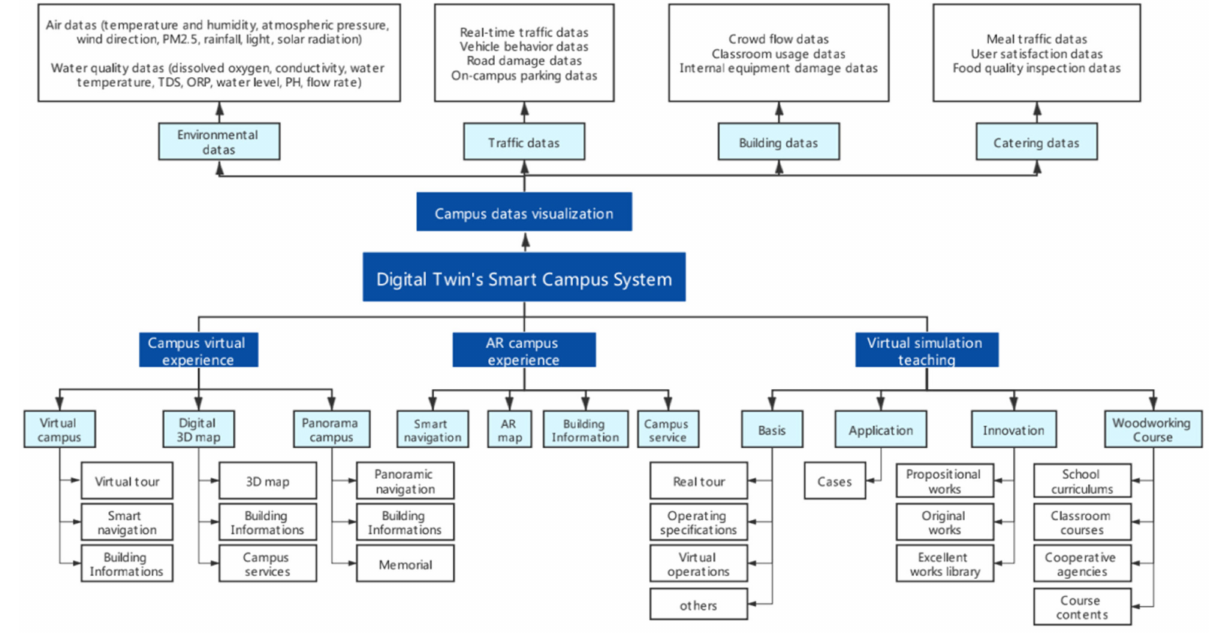
Figure 11. Digital twin smart campus